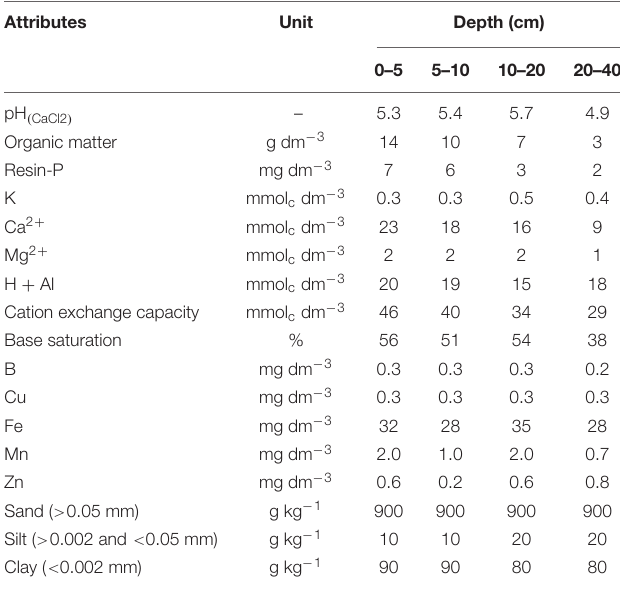
TABLE 1 | Soil surface Ap physical 1 –chemical 2 characterization according to fixed depths.